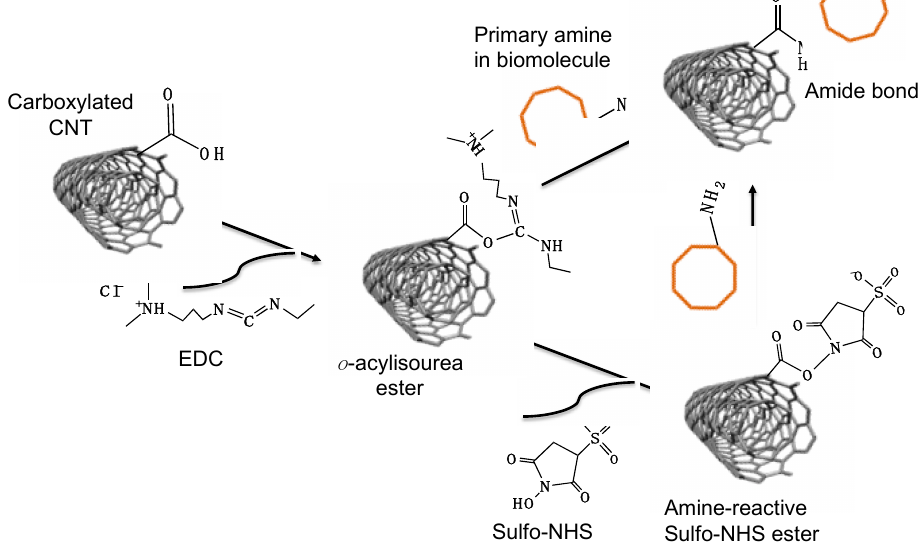
Figure 3. Reaction scheme for EDC and EDC-NHS based covalent crosslinking of biomolecule with carbon nanotube.